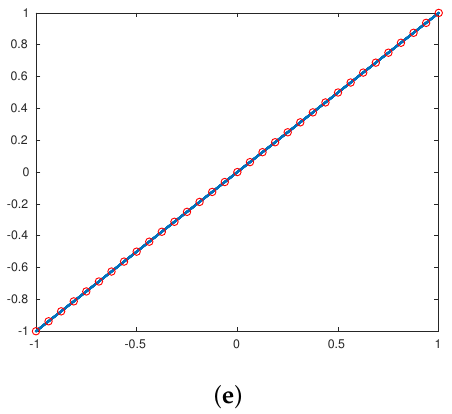
Figure 7. The limit functions in 1d using five subdivision scales; the results shown in ( a – e ) were obtained by S 2 (11), S 3 (13), S 4 (15), S 5 (17), and S 6 (19), respectively, where w = 1 original sampling is represented in ◦ .